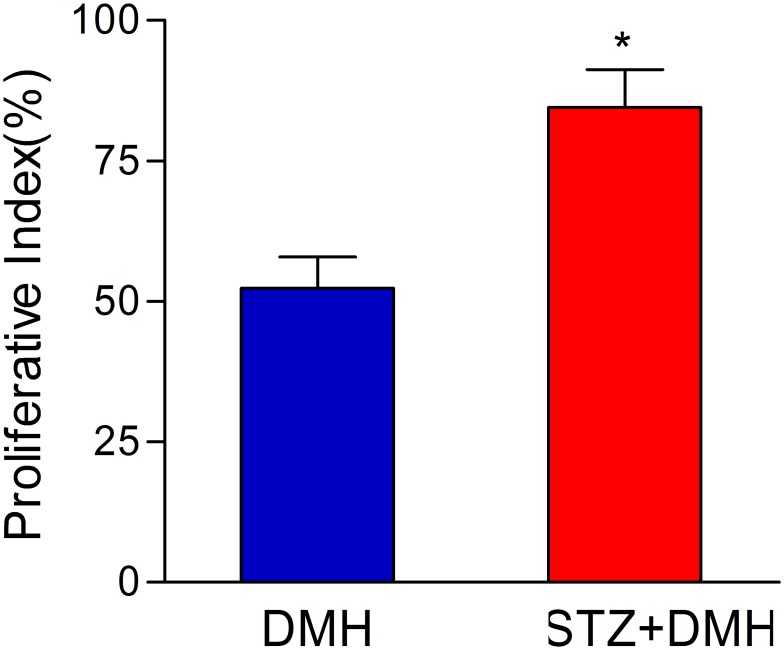
A bar chart demonstrating the proliferation index (PI) of colorectal tumor cells in DMH-induced colon tissues (DMH group and STZ+DMH group).The PI was expressed as the percentage of PCNA-positive nuclei among the total number of cells counted. Values are expressed as mean ± S.E.M. and analyzed using unpaired student’s T test at P<0.05. *P<0.05 vs. DMH group.